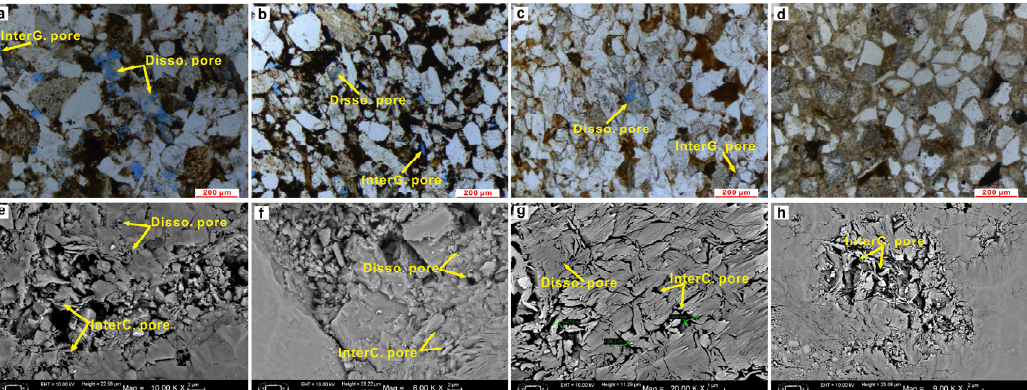
Figure 10. Microscopic characteristics of the reservoir space of shale oil reservoirs in the Chang 7 1-2 sub-member (CTS: ( a ) Disso. pore, interG. pores, well L88, 2279.57 m; ( b ) interG. pores, well L82, 2213.66 m; ( c ) disso. pores, well W336, 2016.95 m; ( d ) lithic arkose, well Z144, 1827.11 m. SEM; ( e )